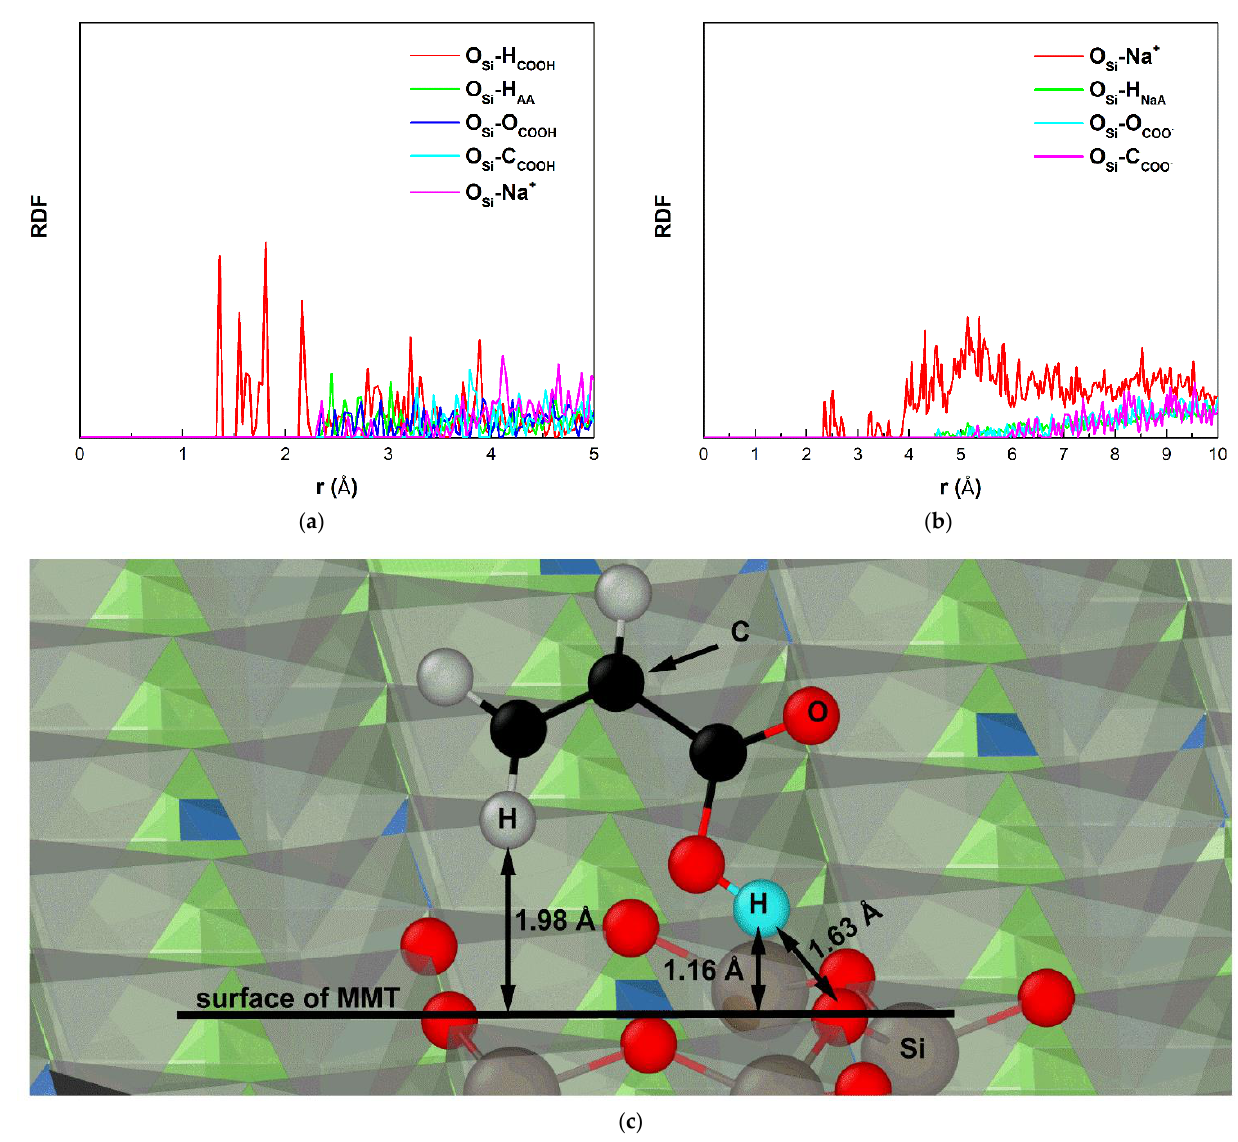
Figure 5. DF functions of O Si – H COOH , O Si – H AA , O Si – O COOH , O Si – C COOH , O Si – Na + and O Si – Na + , O Si – H NaA , O Si – O COO – , and O Si – C COO – atom pairs averaged over the time range from 62 to 63 ps after adding ( a ) acrylic acid, ( b ) sodium acrylate, and ( c ) exemplary acrylic acid molecules in the neighborhood of O Si .